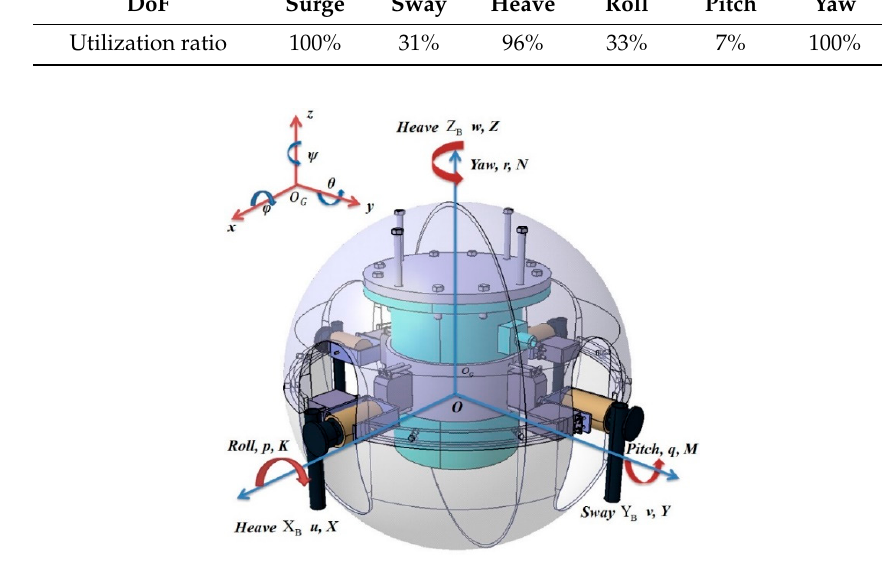
Table 1. Utilization ratio of different DoFs.